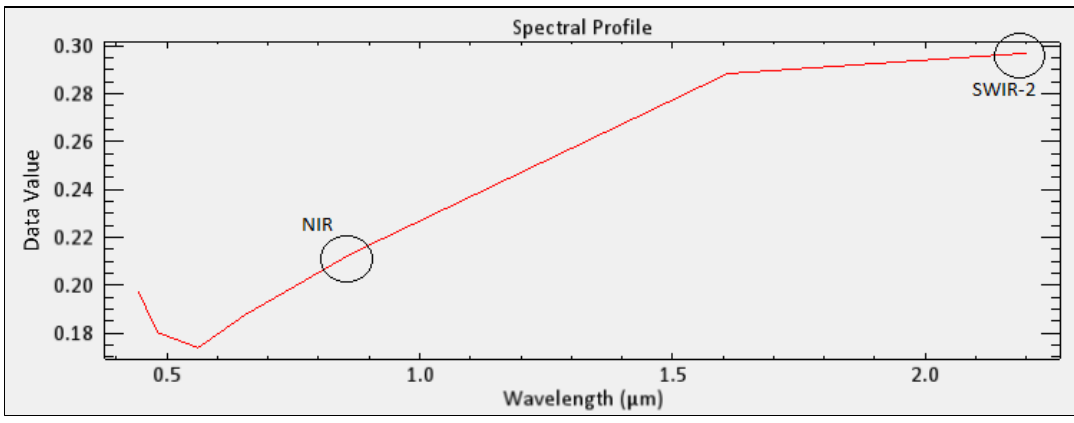
Figure 14. Spectral reflectance of ( a ) clean panels, ( b ) dusty panels with dark patch and ( c ) dusty panels with bright patch. Circle highlights the differences in reflectance of near-infrared and short-wave infrared -2 wavelength.